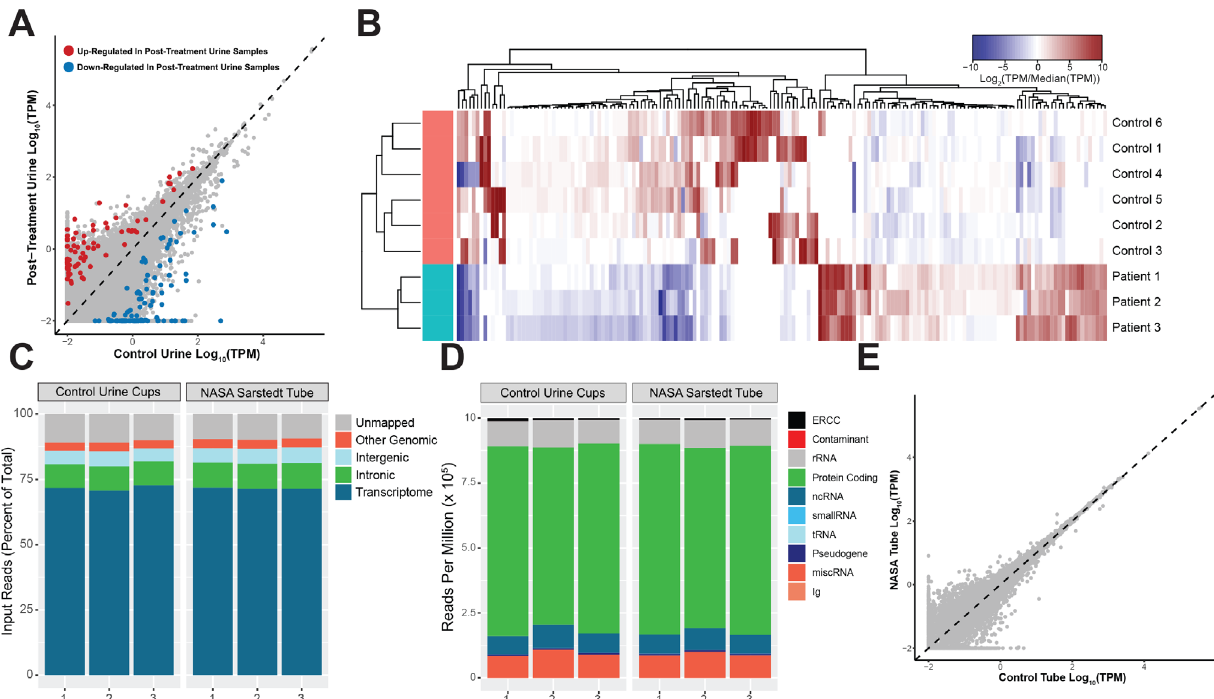
Fig. 4 Urine exosome RNA pro fi les from post-treatment urine samples and feasibility of using the NASA Sarstedt tube for urine collection and exosome RNA readout. A Scatterplot of all genes detected in post-treatment patient and control urine samples. Genes that are up- regulated in post-treatment patients are in red and genes that are down-regulated in post-treatment patients are in blue. B Heatmap showing differential expression of signi fi cantly differentially expressed genes between post-treatment patient (teal) and healthy control (salmon) urine samples. C Stacked bar graphs showing the percentage of RNA-Seq reads mapping to transcriptome, intronic, intergenic, and other genomic regions of exoRNA derived from urine collected and stored using Exosome Diagnostics control urine cups and NASA Sarstedt collection tubes. D Stacked bar graphs showing the number of reads per million (RPM) mapping to various biotypes of exoRNA derived from urine stored using Exosome Diagnostics control urine cups and NASA Sarstedt collection tubes. E Scatterplot of all genes expressed in urine samples stored using Exosome Diagnostics control urine cups and NASA Sarstedt collection